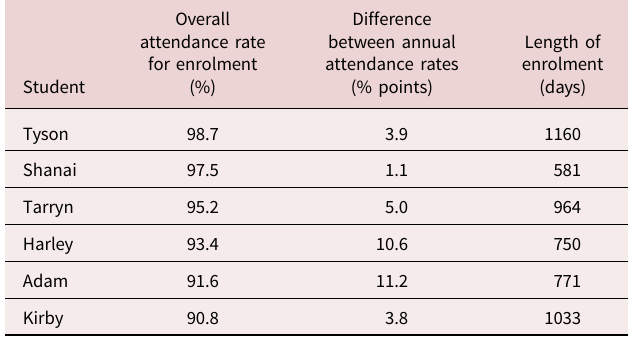
Table 1. Example of six Indigenous students among the top 45 students at Watney that shows students ’ attendance rate for enrolment period and the variation in attendance rate between years and length of enrolment